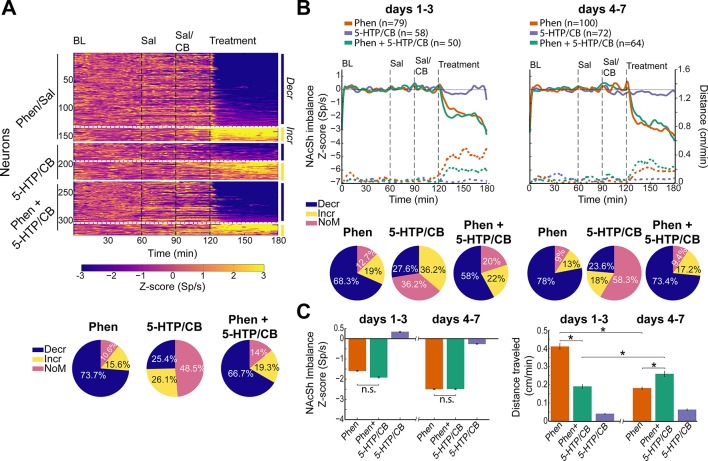
Phentermine (Phen) induces an inhibitory imbalance in population nucleus accumbens shell (NAcSh) activity, and the addition of 5-hydroxytryptophan (5-HTP)/carbidopa (CB) did not reverse the imbalance. (A)
Upper panel: population activity of 325 (out of 423) neurons recorded during 180 min spanning four different epochs including the baseline (BL), Saline (Sal), CB (in the case of 5-HTP), and treatments (Phen, or 5-HTP, or Phen + 5-HTP/CB) indicated by the vertical dotted lines. The activity of each neuron was normalized to z-score relative to BL epoch and plotted in a color-coded peri-stimulus time histogram (PSTH). The horizontal solid white lines separated the neuronal modulations evoked by different drug treatments, whereas the dotted white line separated the NAcSh neuronal activity that decreased (Decr) or increased (Incr) after treatment. Lower panel. Percentage of neurons that decreased or increased firing rate significantly, and non-modulated (NoM) neurons after treatment. (B) The population firing rate (normalized to z-score) in each epoch as a function of days 1-3 block (left panel) and on days 4–7 block (right panel). Note that negative z-scores indicate an inhibitory imbalance (right x-axis). Dashed lines depict the locomotion induced by each treatment (see units in right y-axis). Lower panel. Pie chart of modulation of each treatment for the two blocks. (C)
Left panel, overall average activity 50 min after onset of drug injection (from 130 to 180 min in panel B), as a function of blocks. The right panel depicts the distance traveled in the same time interval for each treatment. * Significantly different with an alpha 0.05. Percentages may not total 100% because of rounding.